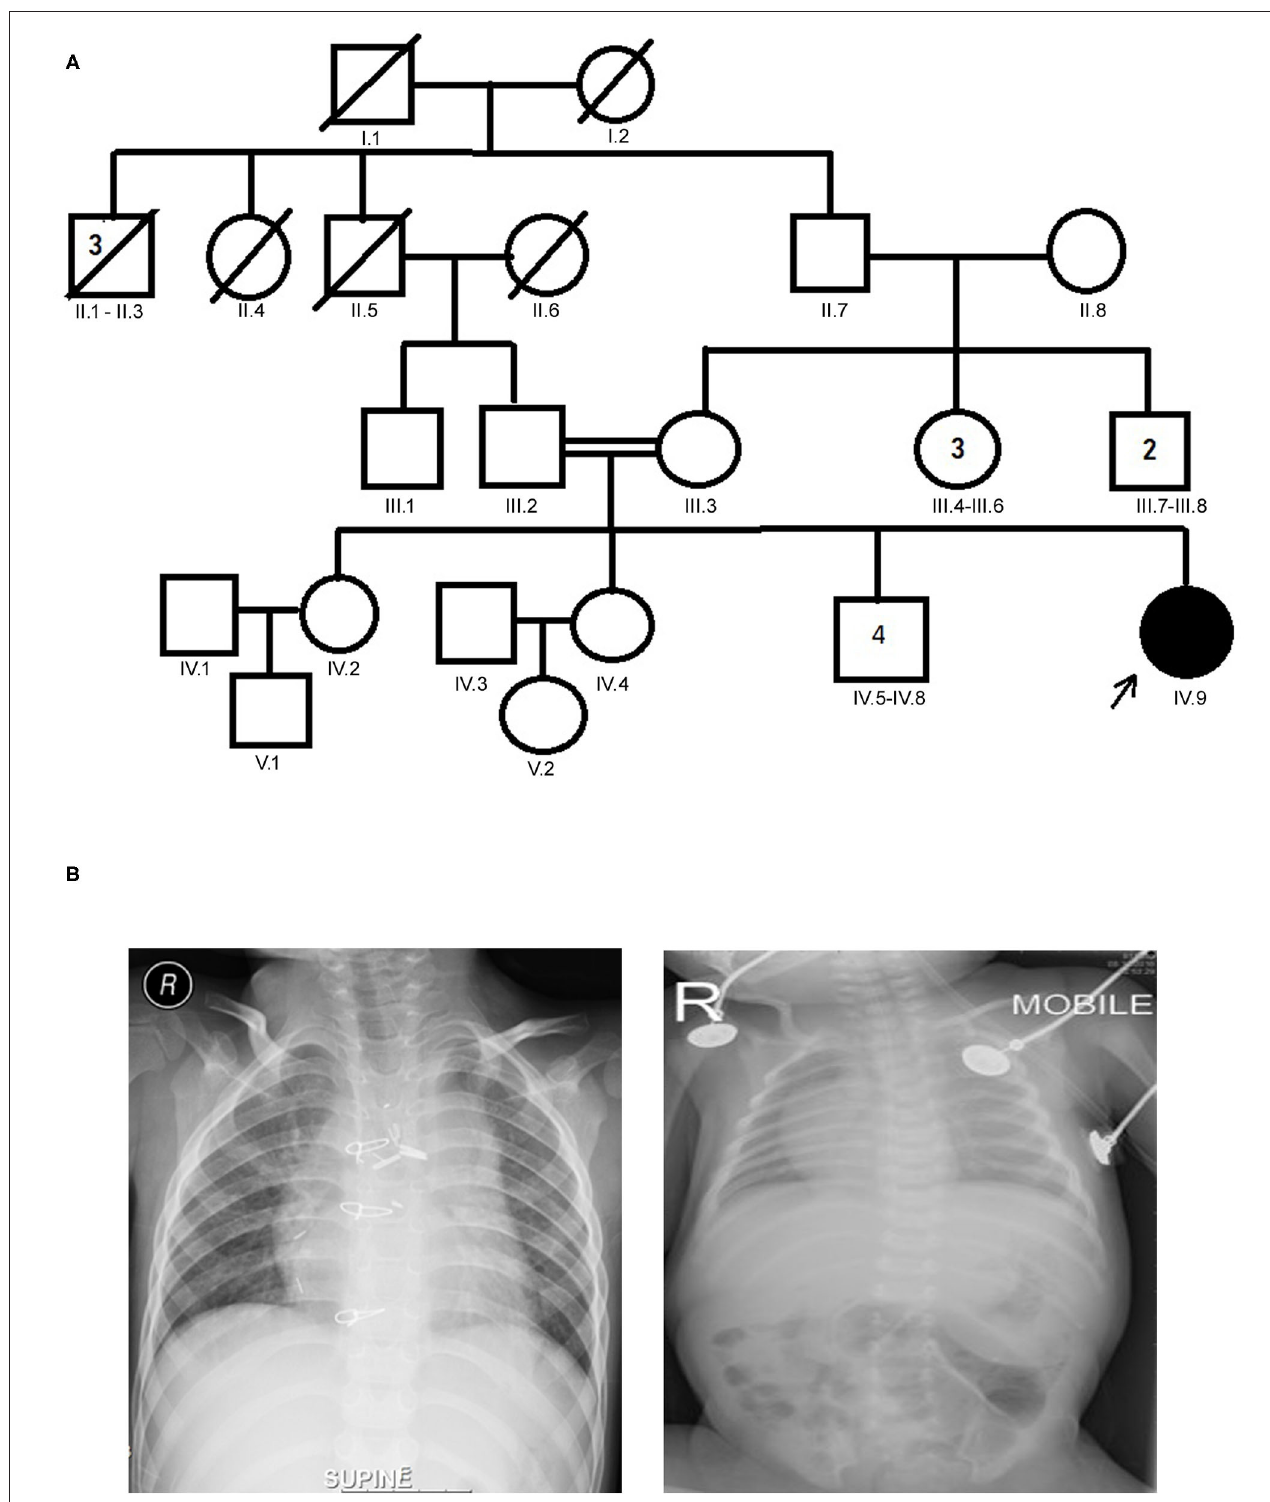
FIGURE 1 | (A) Family pedigree chart of laterality defect (LD) Arab family. Proband is indicated by the arrow. The affected proband (shaded circle) is homozygous of c.2293C > T mutation in MYO1D gene. Both parents were consanguineous (double horizontal lines) and heterozygous carriers of the identified mutation. (B) Chest X-rays showing left isomerism